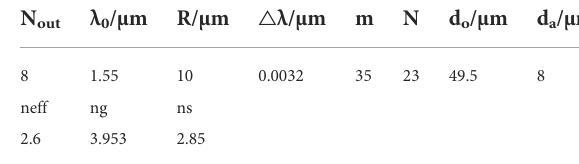
TABLE 3 Design parameters of the